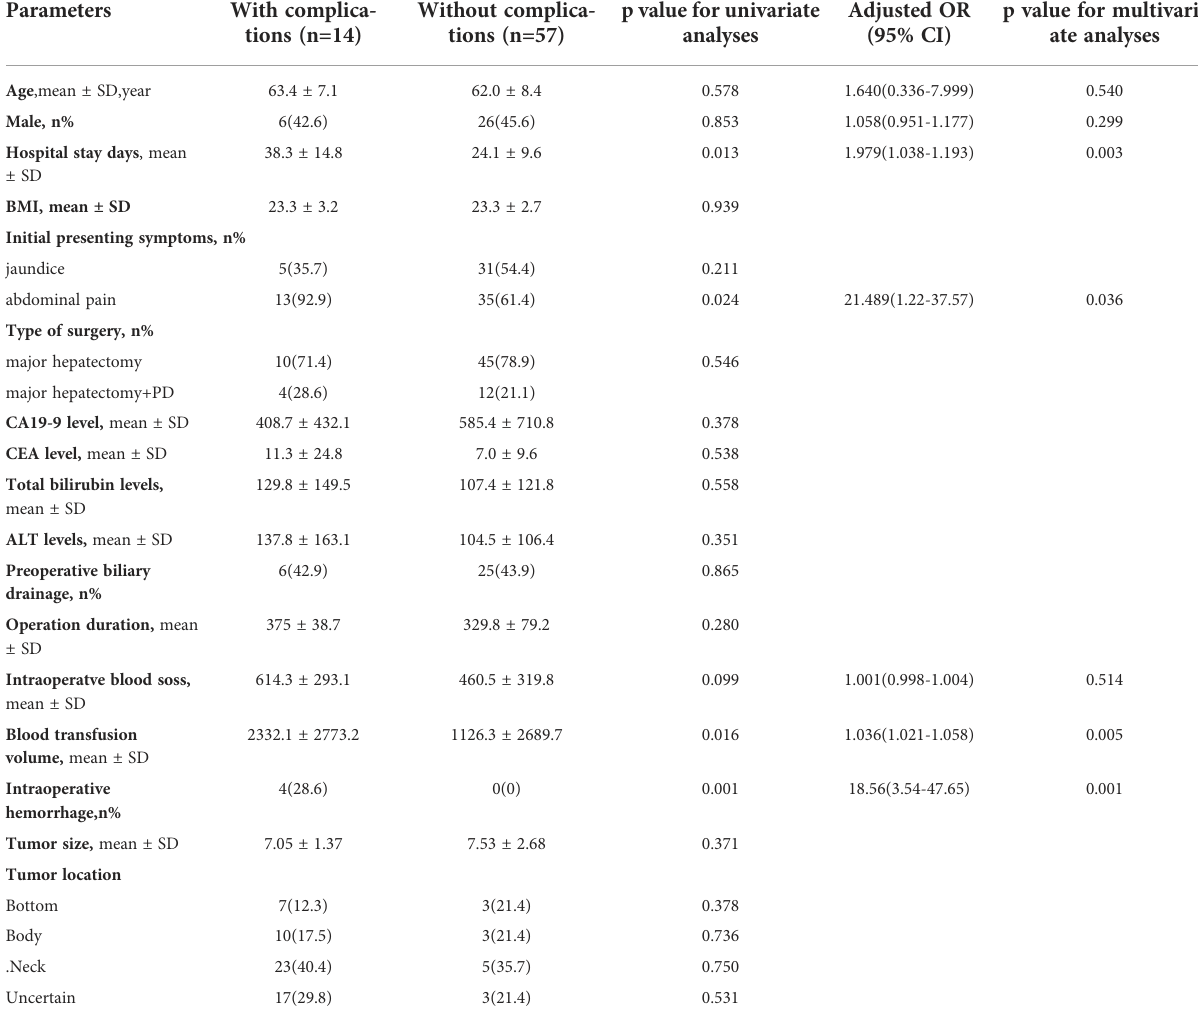
TABLE 3 Univariate and multivariable analyses of risk factors for postoperative complications. Parameters With complica- tions